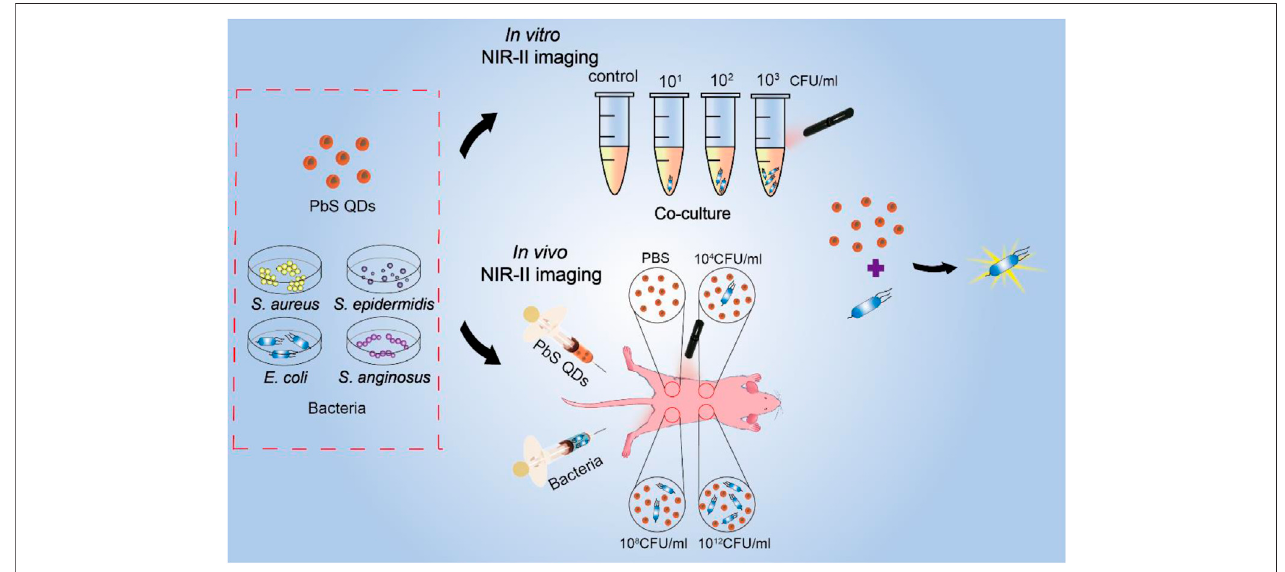
SCHEME 1 | Schematic to represent the experimental